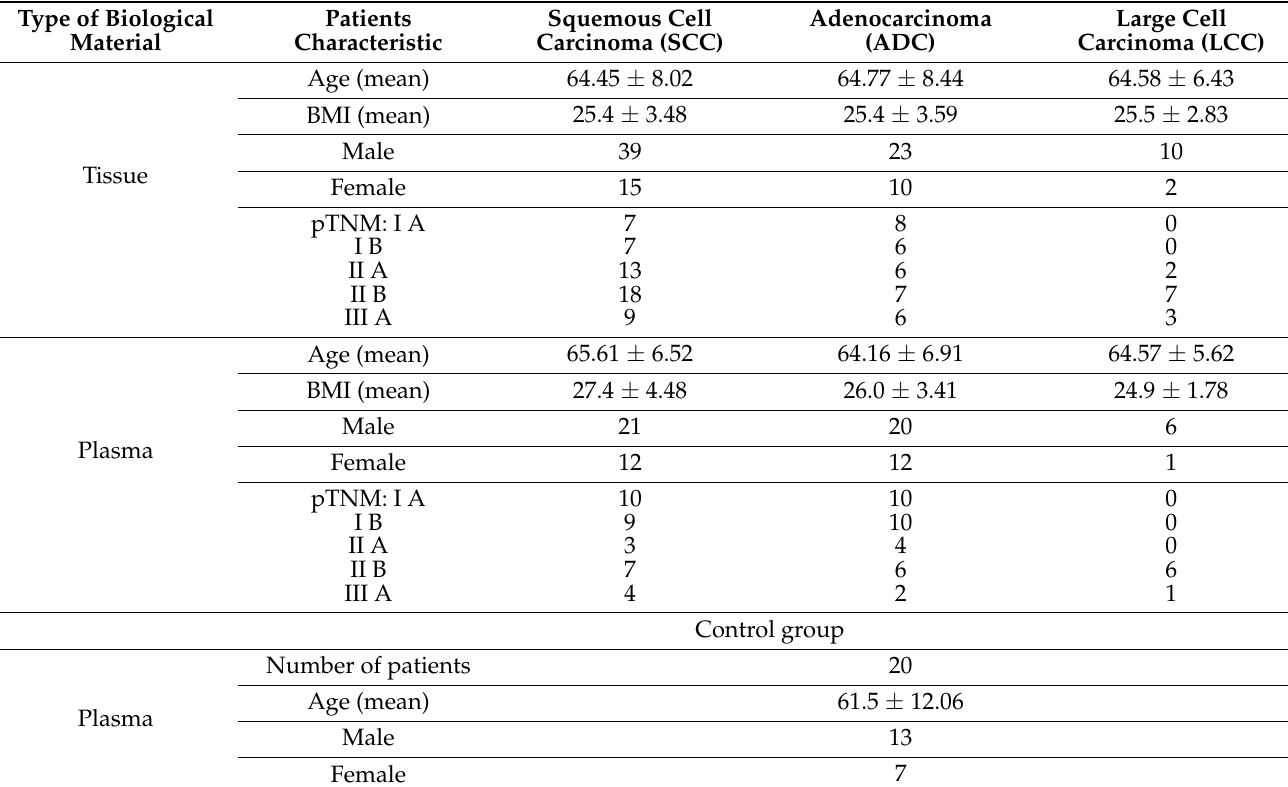
Table 1. Patients’